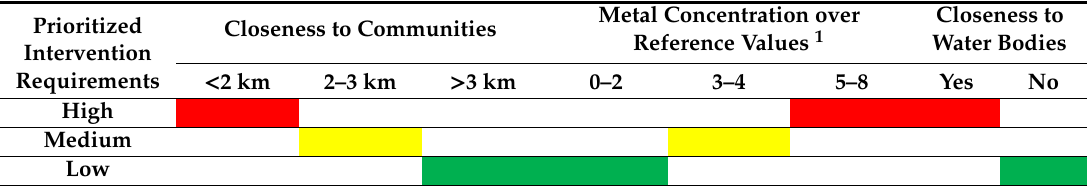
Table 3. Criteria for classifying tailings priority